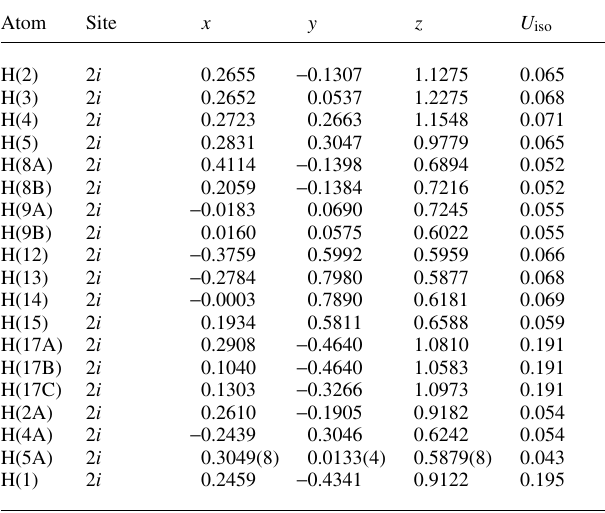
Table 2. Atomic coordinates and displacement parameters (in Å 2 )